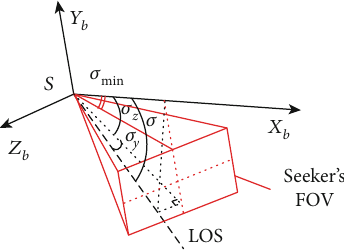
Figure 3: 3D angular con fi guration of the o ff -axis strapdown